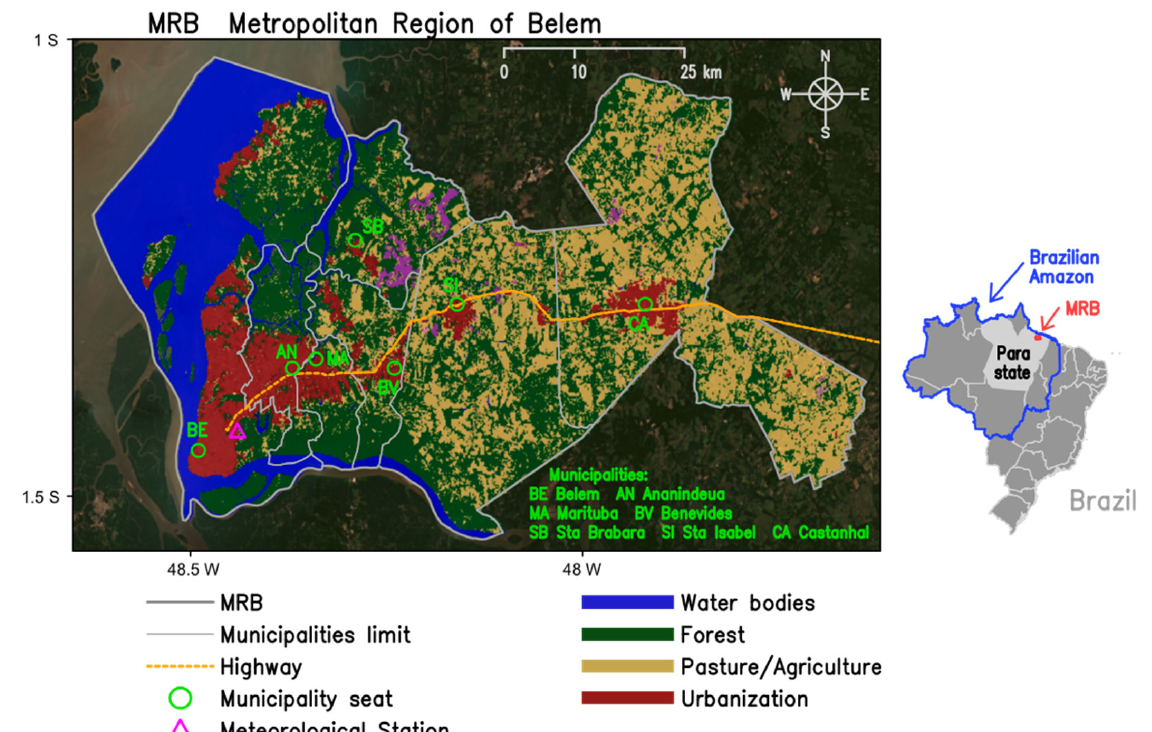
Figure 1. Study area in the MRB with the 2020 landcover map, locations of the seven municipalities and meteorological station, and the main highway crossing the region.